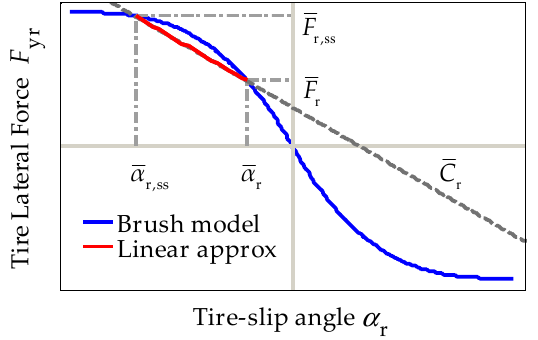
α and α are the tire slip angle at time r r,ss F and F are r r,ss